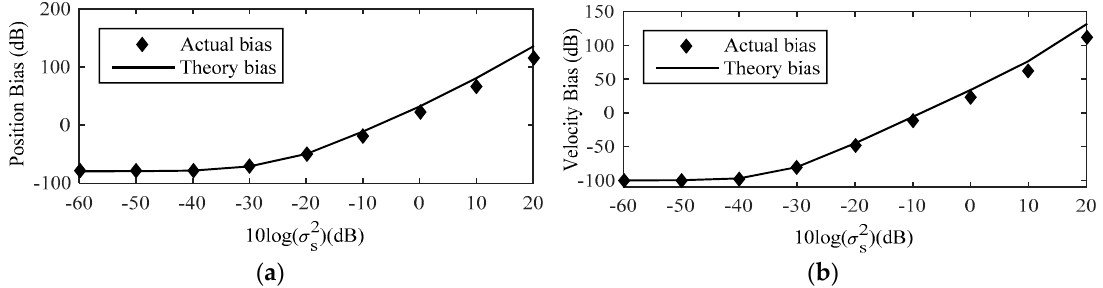
Figure 10. Comparison between theoretical and actual bias of far-field source location estimate by MLE. ( a ) Position Bias; ( b ) Velocity Bias.